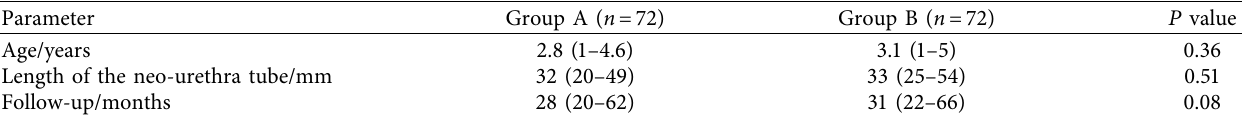
Figure 2: Steps of the transverse tubularized preputial island flap (Duckett’s) technique. (a) Penoscrotal hypospadias. (b) Inner preputial flap is tubularized over Nelaton’s catheter. (c) Neo-urethral tube is transposed to the ventral aspect of the penis with closure of skin. (d) Side view after repair was completed. Table 1: Demographic data and perioperative characteristics.